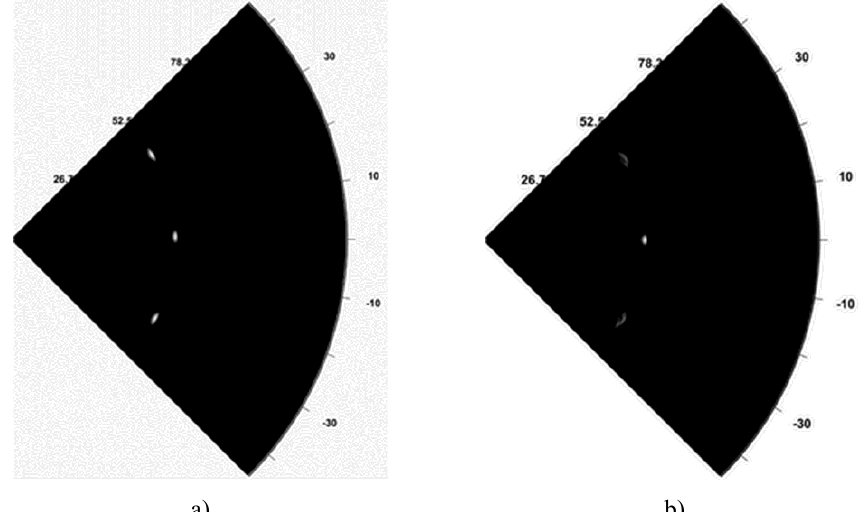
Fig. 2. The reconstructed images of the target signal with a) weighted coefficients and b) with complex correlation